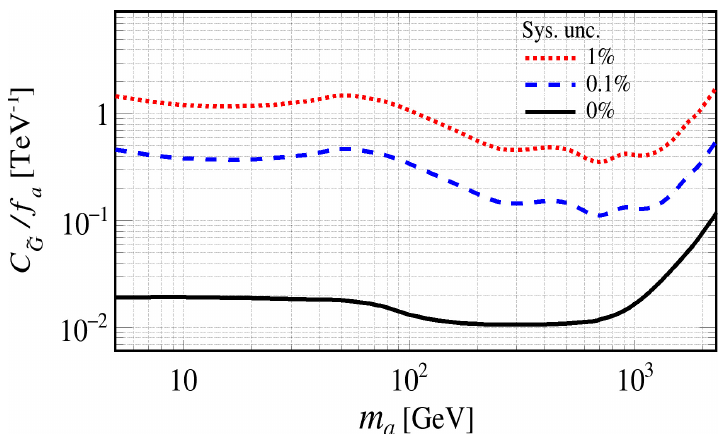
Figure 6 . Upper limits on the model parameter C ˜ /f a at 2- σ significance for ALP mass m a in G the range 5–2300 GeV with 1% (dotted, red), 0.1% (dashed, blue) and 0% (solid, black) relative systematic uncertainties on the number of total background events at the HL-LHC with a center- of-mass energy of 14 TeV and an integrated luminosity of 3 ab − 1